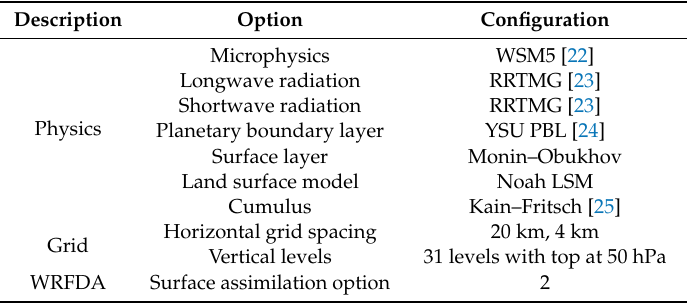
Table 1. Overview of WRF model configuration parameters and physical schemes